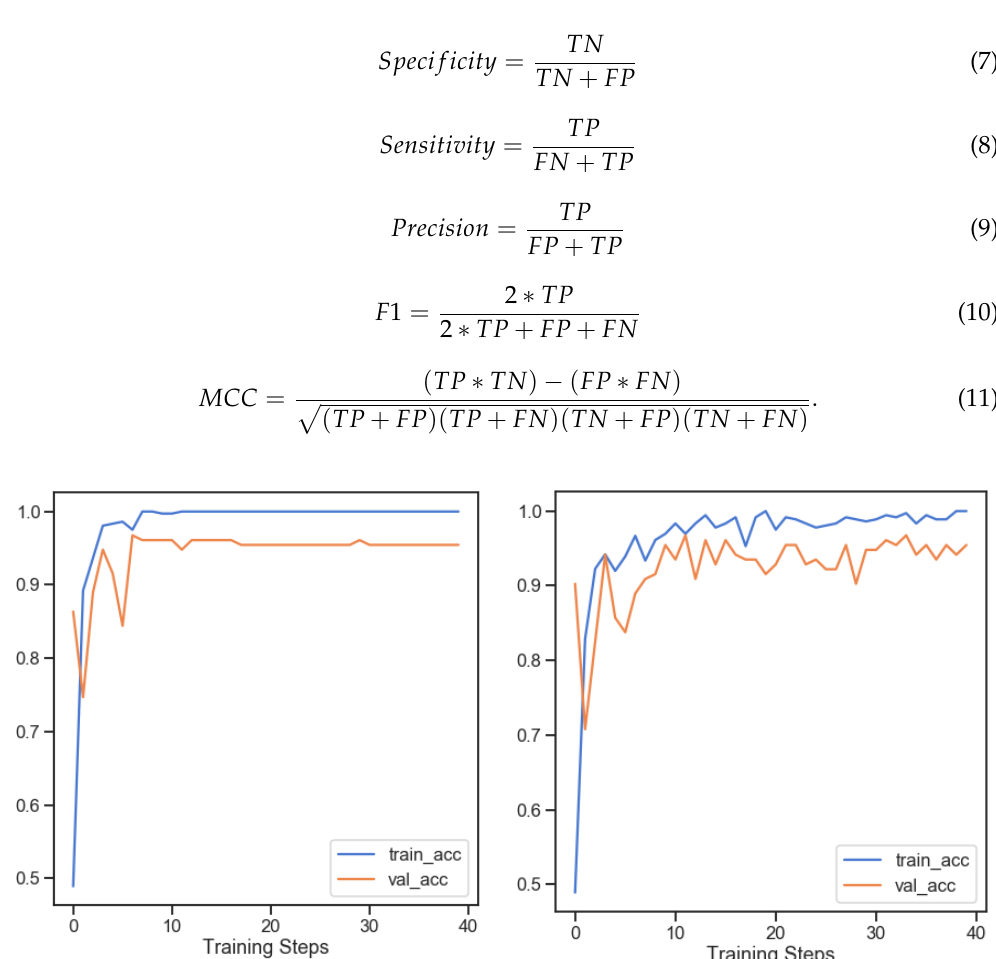
Figure 7. Accuracy (training and validation) 40, 50 epochs.